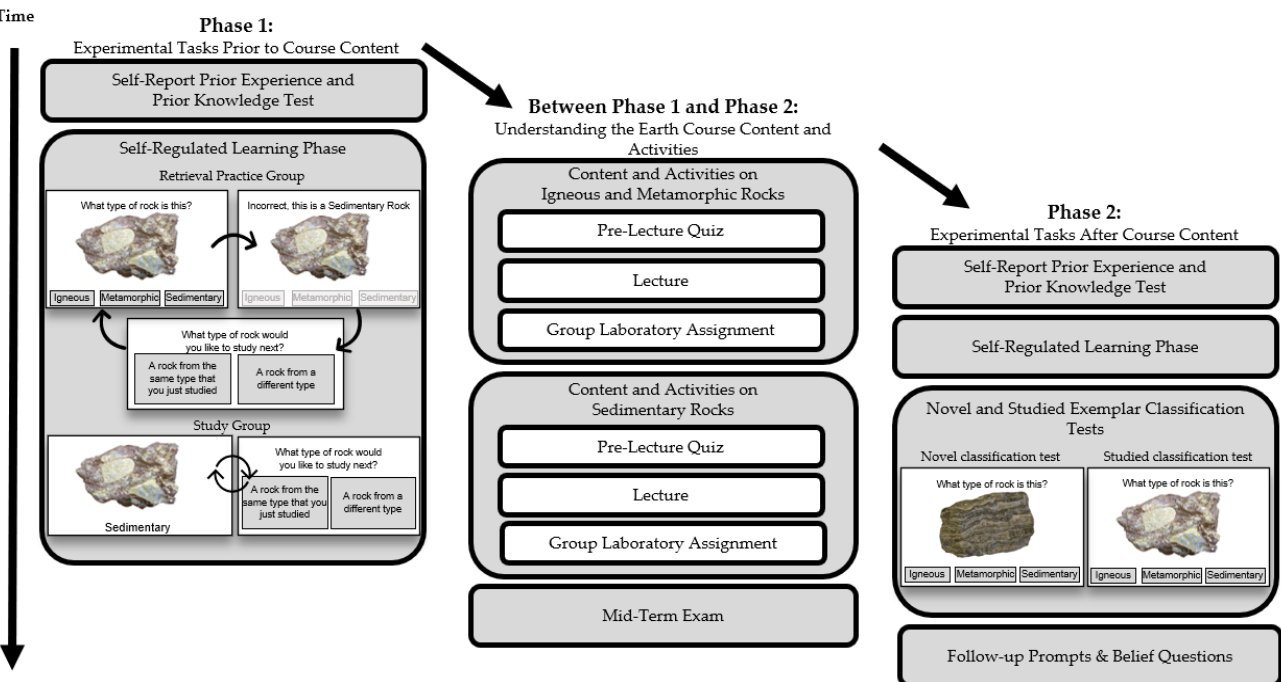
Figure 1. Overview of the experiment tasks and timeline. During the self-regulated learning phase, participants were randomly assigned to the retrieval practice group or study group. Group assign- ment was maintained during the Phase 2 self-regulated learning phase.